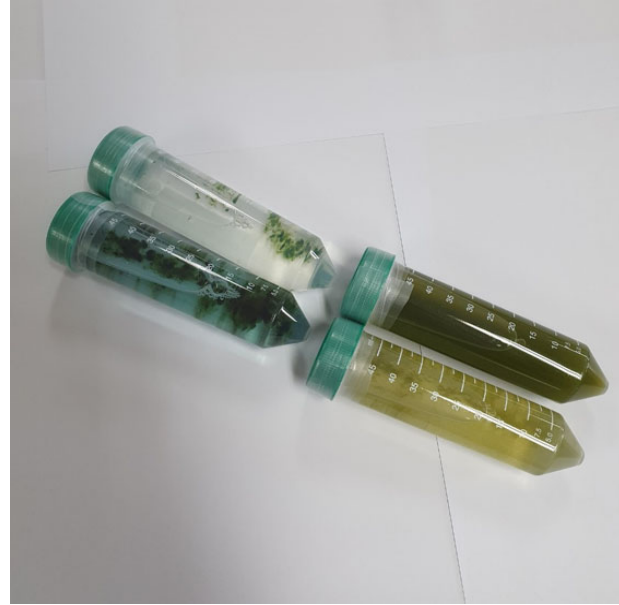
Figure 1. Algae samples in the culture medium.